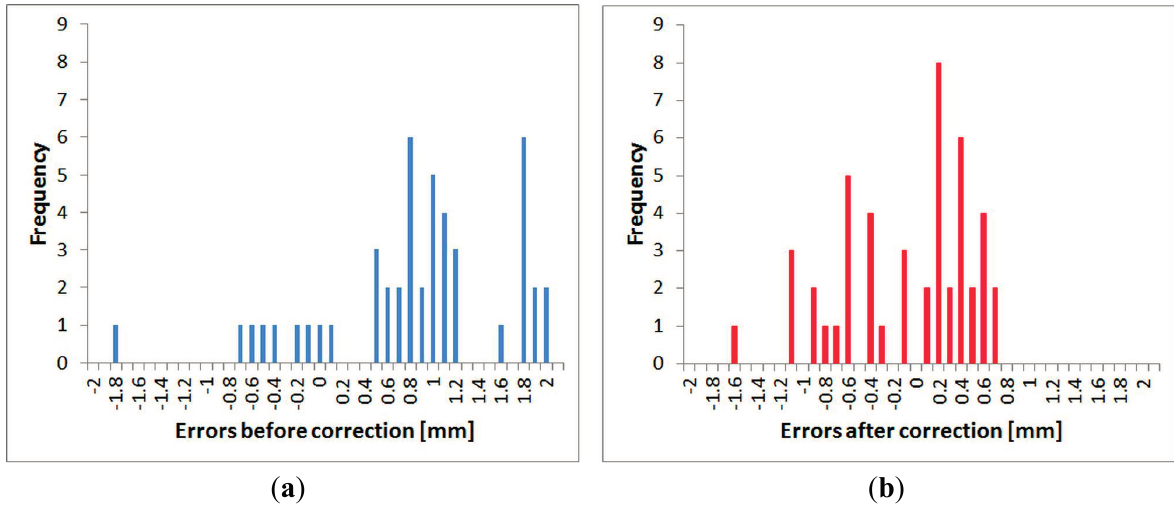
Figure 39. Distribution of the errors–Trimble M3: ( a ) before the correction; ( b ) after the